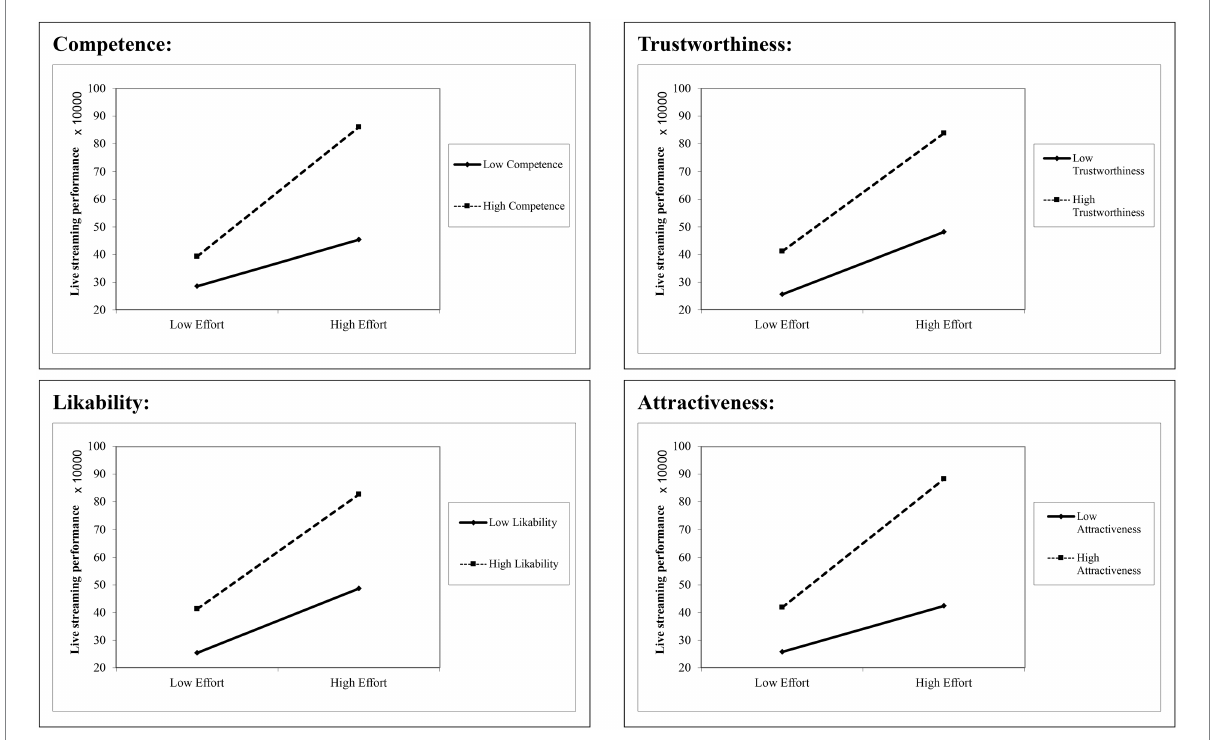
FIGURE 2 Relationship between broadcaster effort and live streaming performance for high and low levels of each dimension of broadcaster